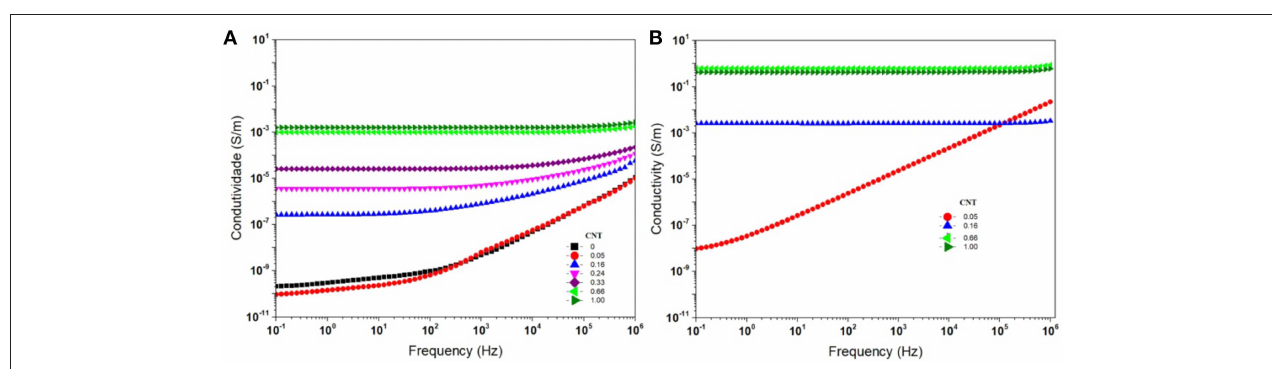
FIGURE 8 | AC conductivity of PS/PBAT composites as a function of the pCNT content. Systems compression molded at 180 ◦ C (A) and at 200 ◦ C (B) .